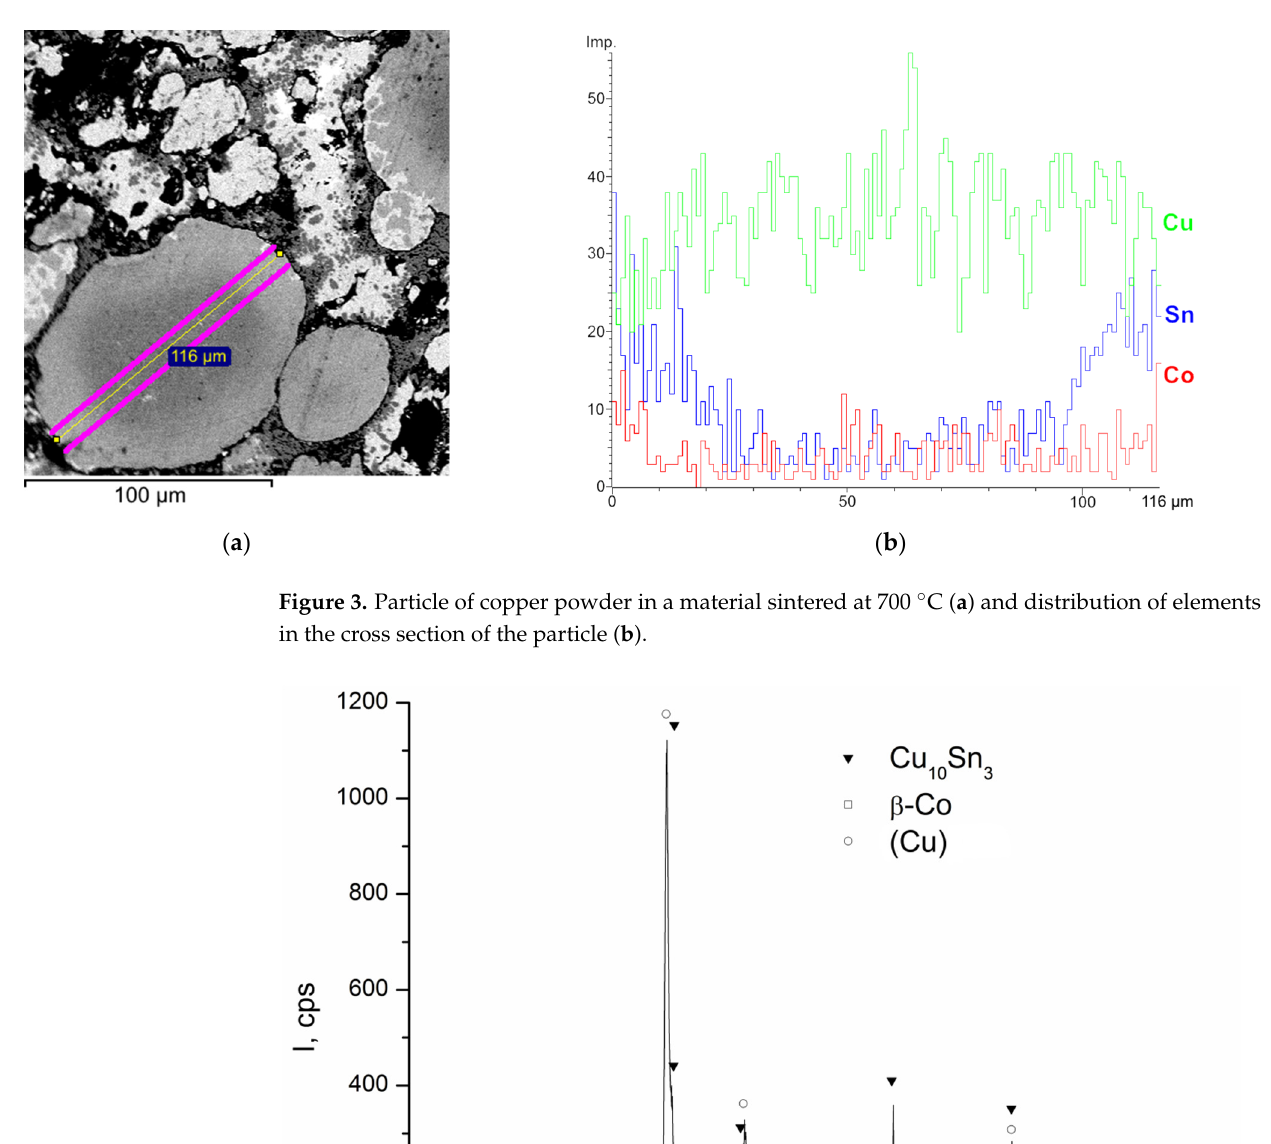
Figure 5. The effect of sintering temperature on porosity of the metallic binders. 3.2. Structure and Element Composition of the Interface Layer between the Coating Binder and the Steel Base During use of the grinding wheels, significant stresses can emerge in the dia- mond-containing coating. To maintain the integrity of the coating-to-base composition, the binder of the coating must feature sufficiently strong adhesion to steel. With regard to this, metallographic studies of the interface regions between the coating binders and the steel bases have been conducted. At the sintering temperatures of 780–820 °C, a layer consisting of cobalt with the microhardness of 118–161 HV0.01 is formed at the interface of the steel base and the binder (Figure 6). This is indicative of the fact that reprecipitation of cobalt from the liq- uid phase onto the steel base occurs at the temperature of sintering. Meanwhile, there is almost no volume diffusion of cobalt into steel. Diffusion regions the between steel and the cobalt layer are not observed either. The interface layer has no brittle intermetallic